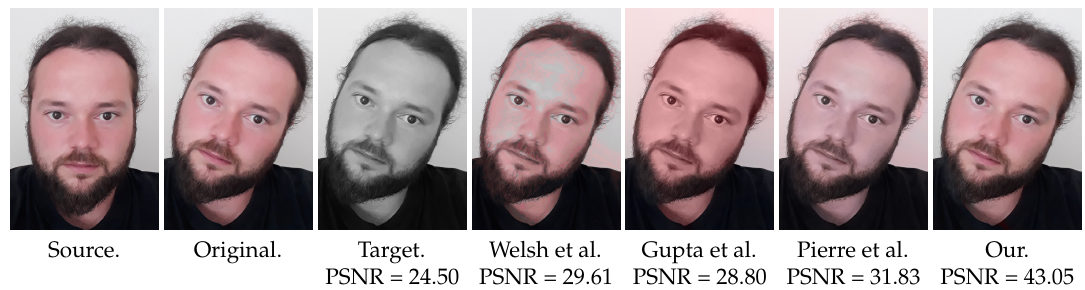
Figure 8. Results on a color image turned into a gray-scale one for a quantitative comparison.